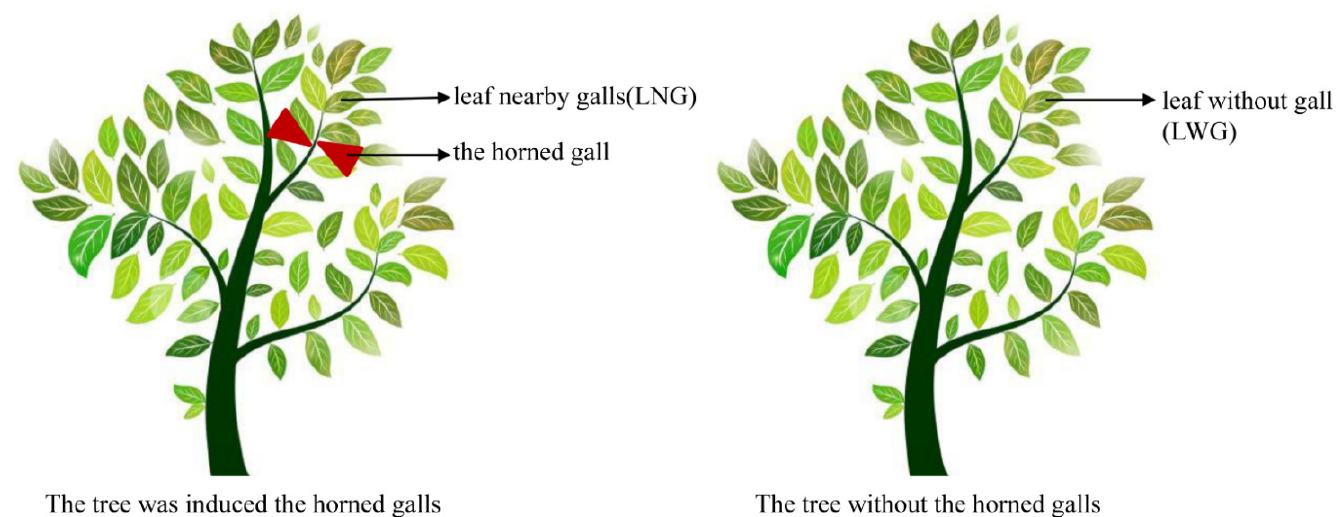
Figure 7. The samples in this study.